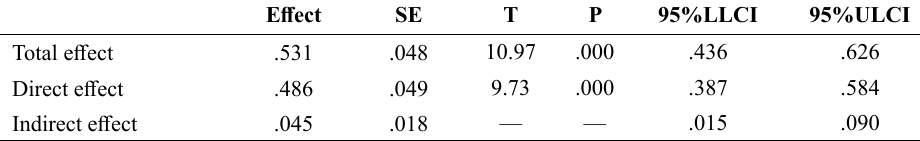
Results for mediation effects using bootstrap